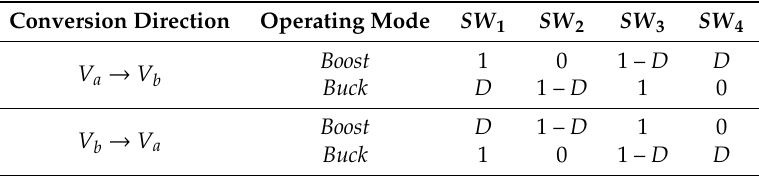
Table 1. Switching states of the proposed